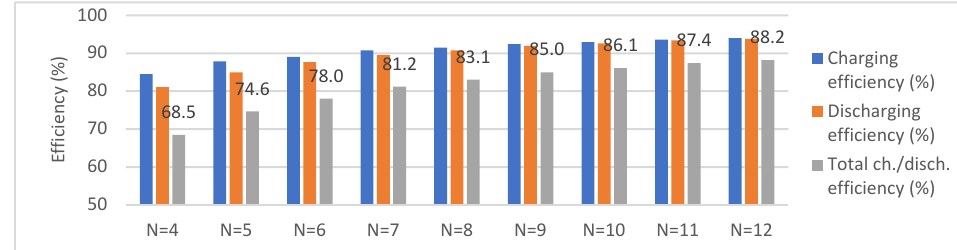
Figure 19. Comparative diagrams of charging, discharging, and total charging/discharging efficiency diagrams of the SC circuit at different numbers of phases.